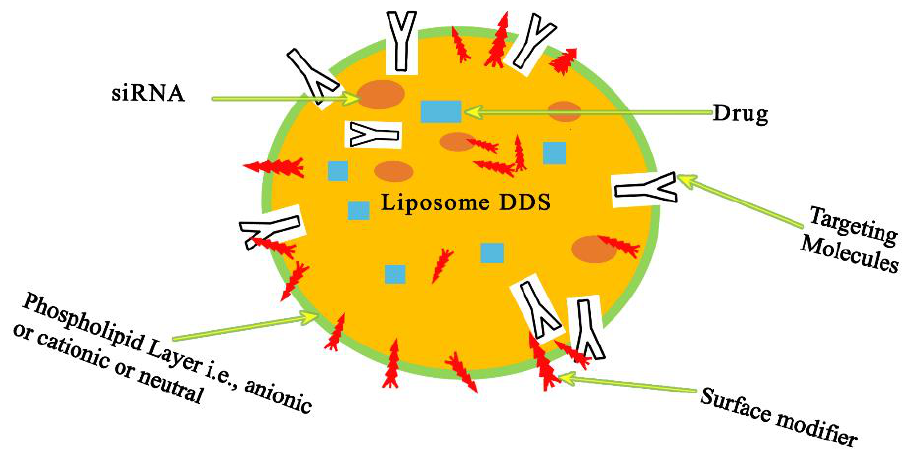
Figure 4. Liposome-based carriers are sphere-shaped vesicles made of synthetic or natural phospholipids. Surface-modifier and -targeting groups can be conjugated to the outer surface. Phospholipids naturally form a bilayer upon aqueous dispersion, with the non-polar tails facing one other and the polar heads facing towards the aqueous phase. Hydrophilic molecules and RNAs are incorporated into the resulting inner core, while hydrophobic molecules are encapsulated in the lipid bilayer. Adapted and modified from [81] under the Creative Commons license.